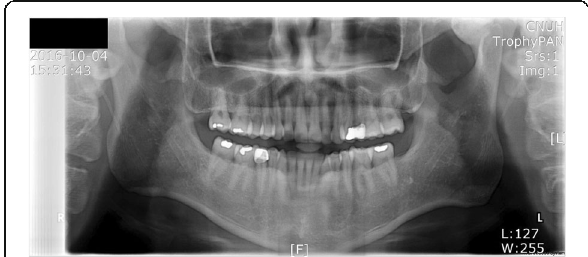
Fig. 3 Proliferation of the left condylar head could be easily checked